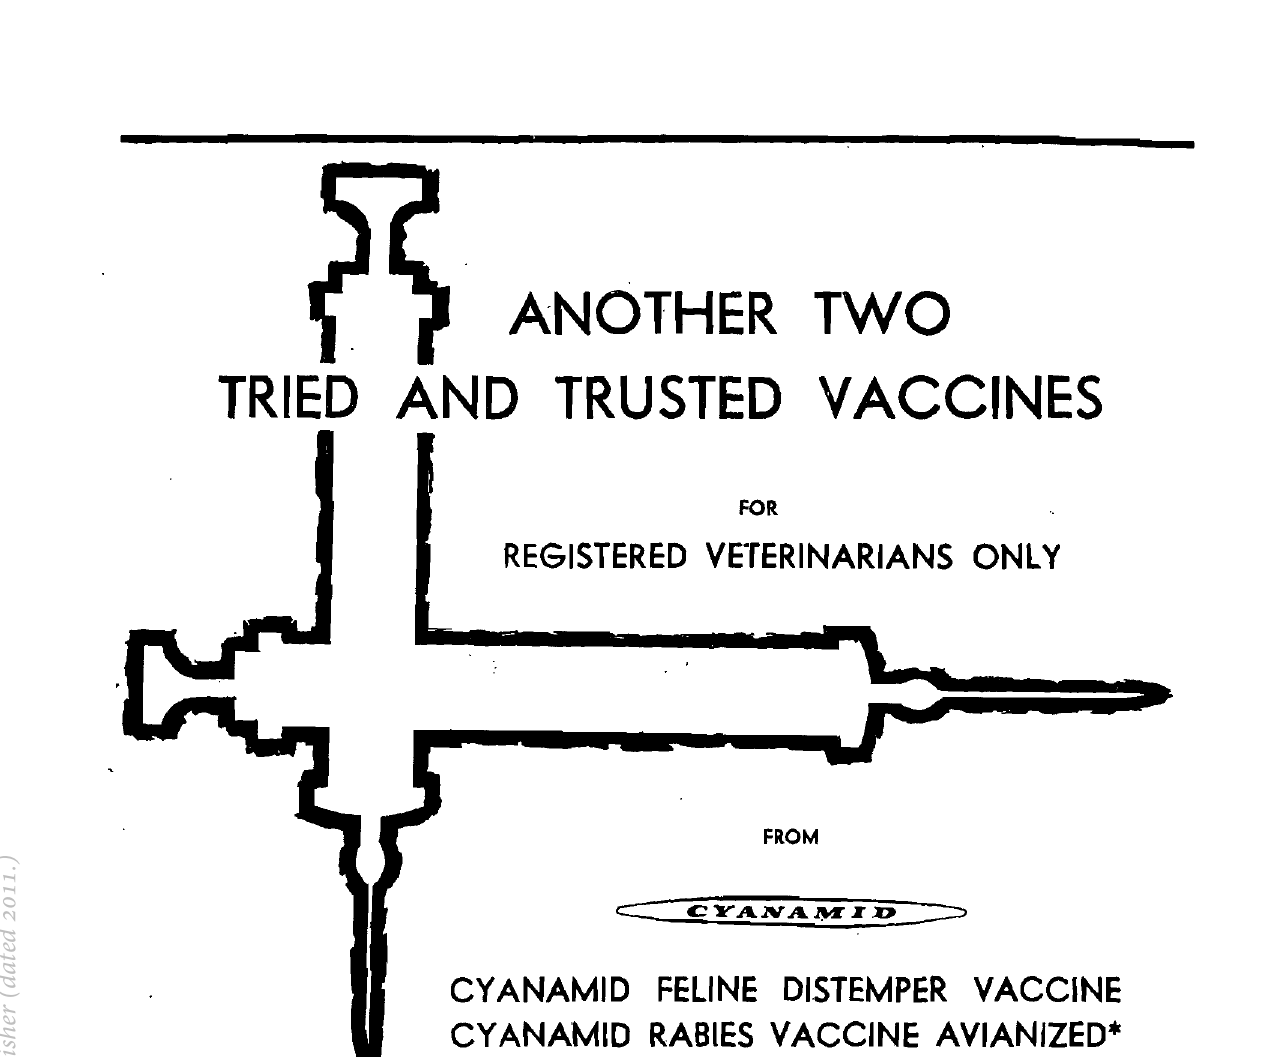
CYANAMID FELINE DISTEMPER VACCINE 2 x 2 cc VIALS WITH DILUENT & CERTIFICATES CYANAMID RABIES VACCINE lOx I DOSE VIALS WITH DILUENT, COLLAR TAGS & CERTIFICATES per dose RO.55 10 DOSE VIALS WITH DILUENT, COLLAR TAGS &